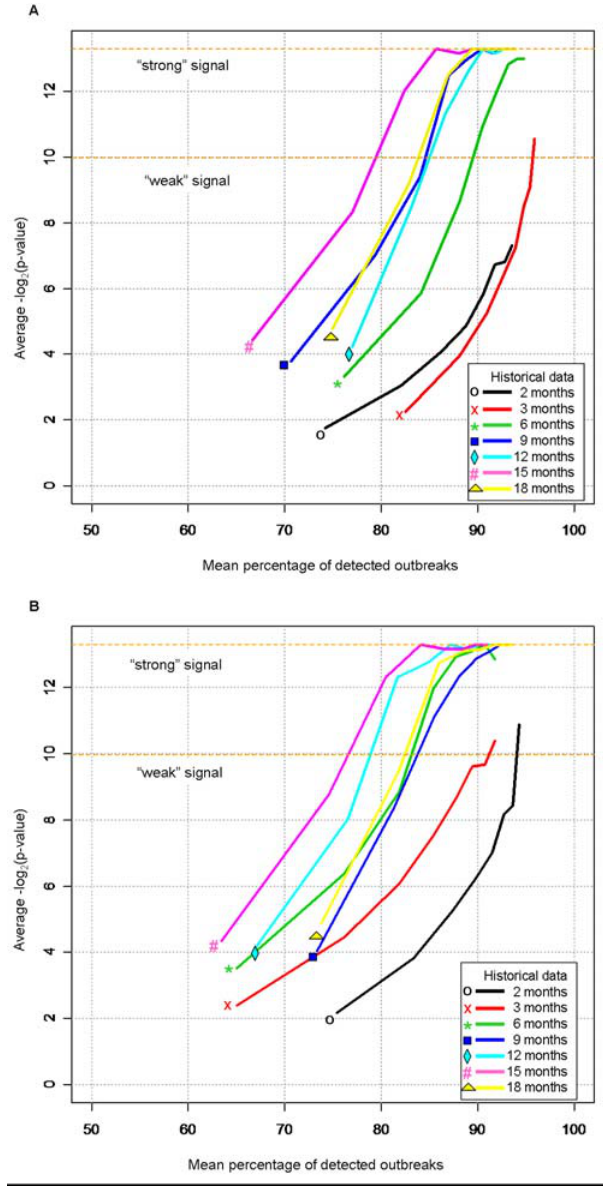
Figure 6. Sensitivity of detection of simulated outbreaks with varied amounts of historical data using (A) census tract centroids and (B) individual addresses. To determine the significance of detected simulated outbreaks with varying amount of historical data a fixed time window of one month was used. The orange dashed lines represent what the authors designate as significant ‘‘weak’’ and ‘‘strong’’ signals corresponding to p-values of 0.001 and 0.0001, respectively.